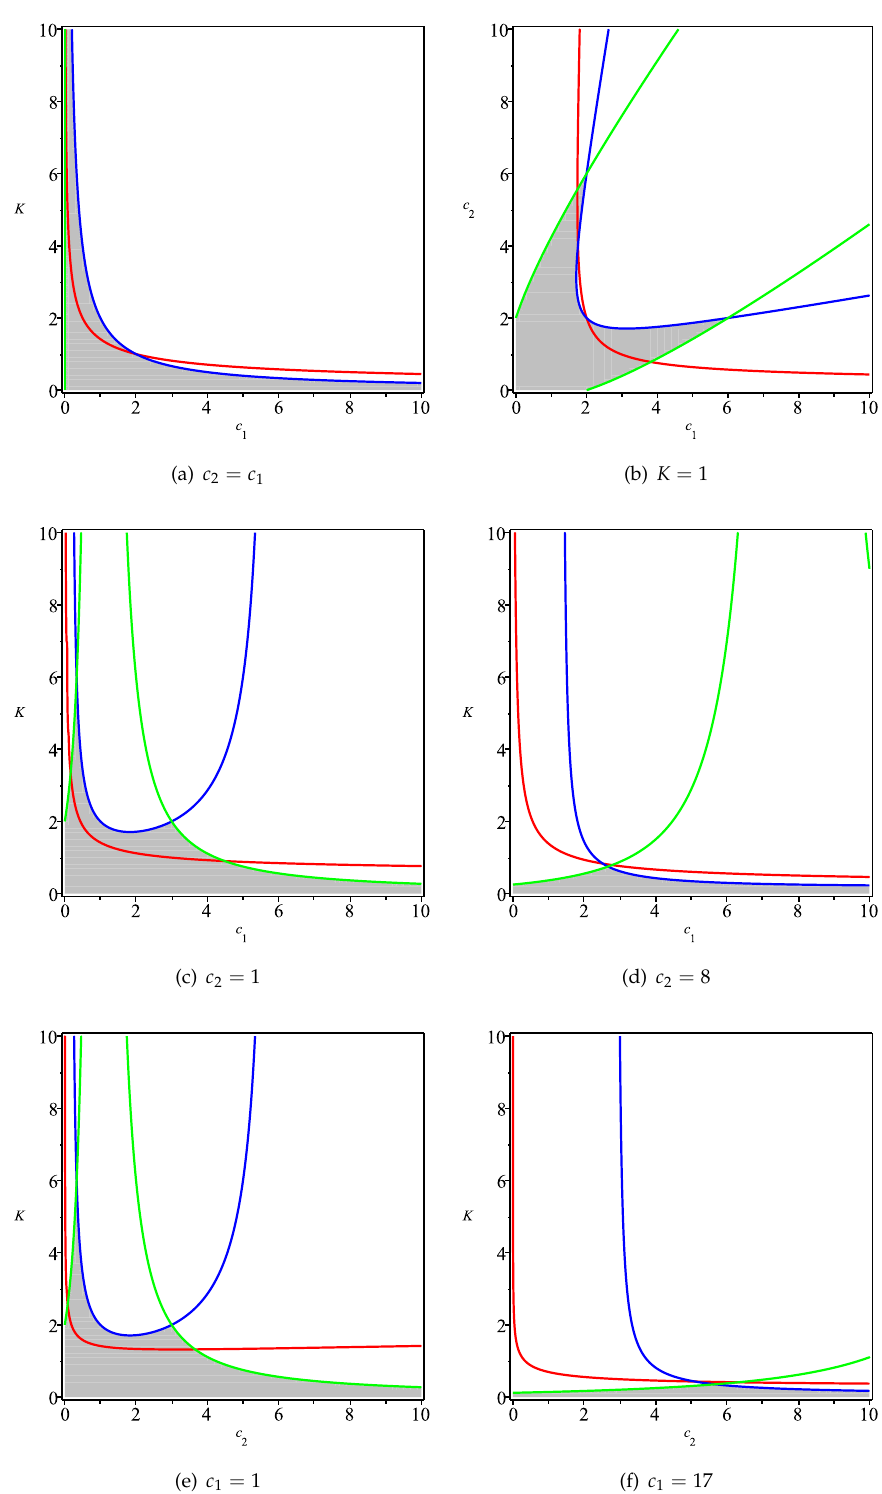
Figure 2. The 2-dimensional subspaces of the parameter values with one parameter fixed. The curves corresponding to N = 0, L 1 = 0 and L 2 = 0 are marked in red, blue and green, respectively. For each case, the model considered in this paper is locally stable in the region surrounded by the red line and the two axes; the analogue under linear costs is locally stable in the grey region that is surrounded by the blue, the green lines and the two